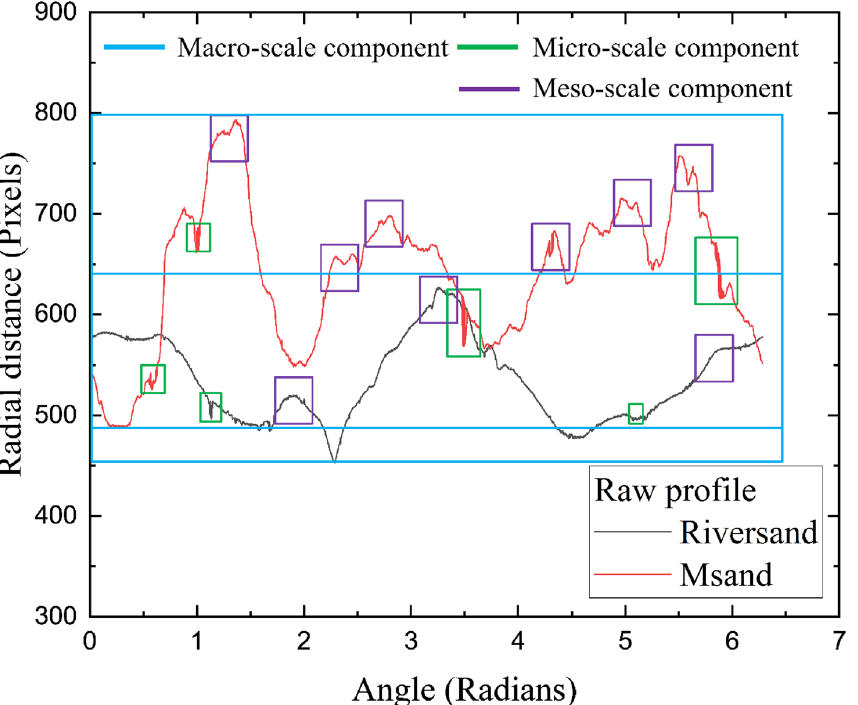
Figure 10. Raw profiles of typical river sand and Msand particles with multiscale shape components